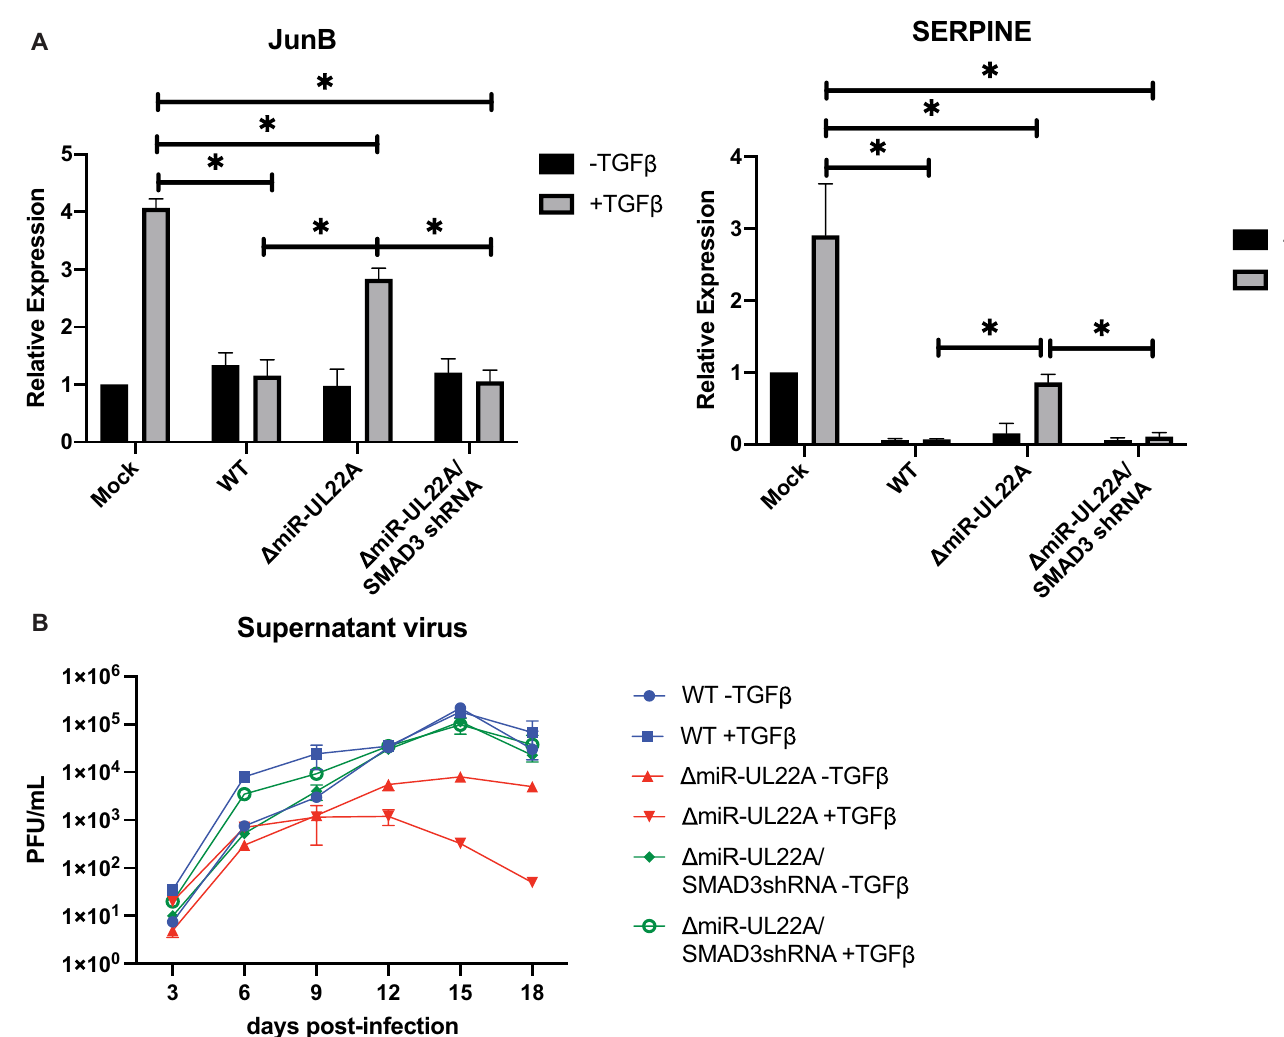
Fig 3. Targeting SMAD3 for downregulation is necessary for efficient lytic replication. (A) NHDF were infected with the indicated viruses for 48 hours followed by overnight serum starvation and stimulation with recombinant TGF β (100pg/mL) for 4 hours. RNA was isolated and subjected to qRT-PCR for JunB and SERPINE. Experiments were performed in triplicate. � p < 0.05 by two tailed Student’s t test. (B) NHDF were infected at 0.01 PFU/mL for 2 hours. 100pg/mL TGF β was added immediately after infection and every 3 days throughout the experiment. Samples were harvested at the indicated timepoints and titered on NHDF. Experiment was performed in